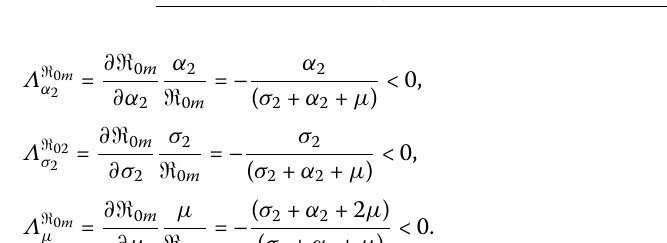
Treatment rate of meningitis Diseases causing death